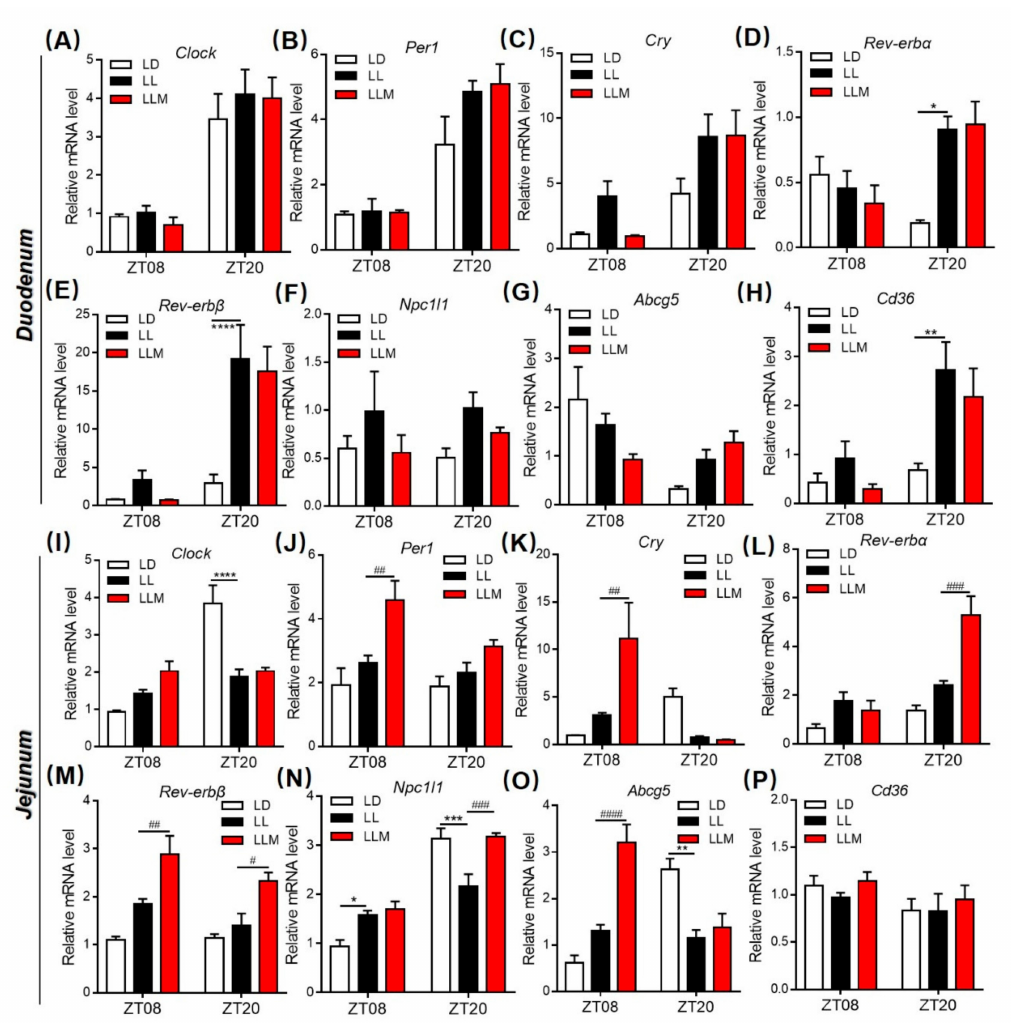
Figure 8. Melatonin regulates lipid absorption and excretion by modulating circadian and lipid transporter gene expression. ( A – H ) The expression of various circadian clock genes ( Clock , Per1 , Cry , Rev - erb α , and Rev - erb β ) and lipid transporter genes ( Npc1l1 , Abcg5 , and Cd36 ) was measured in the duodenum at ZT08 and ZT20. ( I – P ) The expression of various circadian clock genes ( Clock , Per1 , Cry , Rev - erb α , and Rev - erb β ) and lipid transporter genes ( Npc1l1 , Abcg5 , and Cd36 ) was measured in the jejunum at ZT08 and ZT20. Values are presented as the mean ± SEM. N = 3–6, * p < 0.05; ** p < 0.01; *** p < 0.001 compared with LD, # p < 0.05; ## p < 0.01; ### p < 0.001 compared with LL by two-way